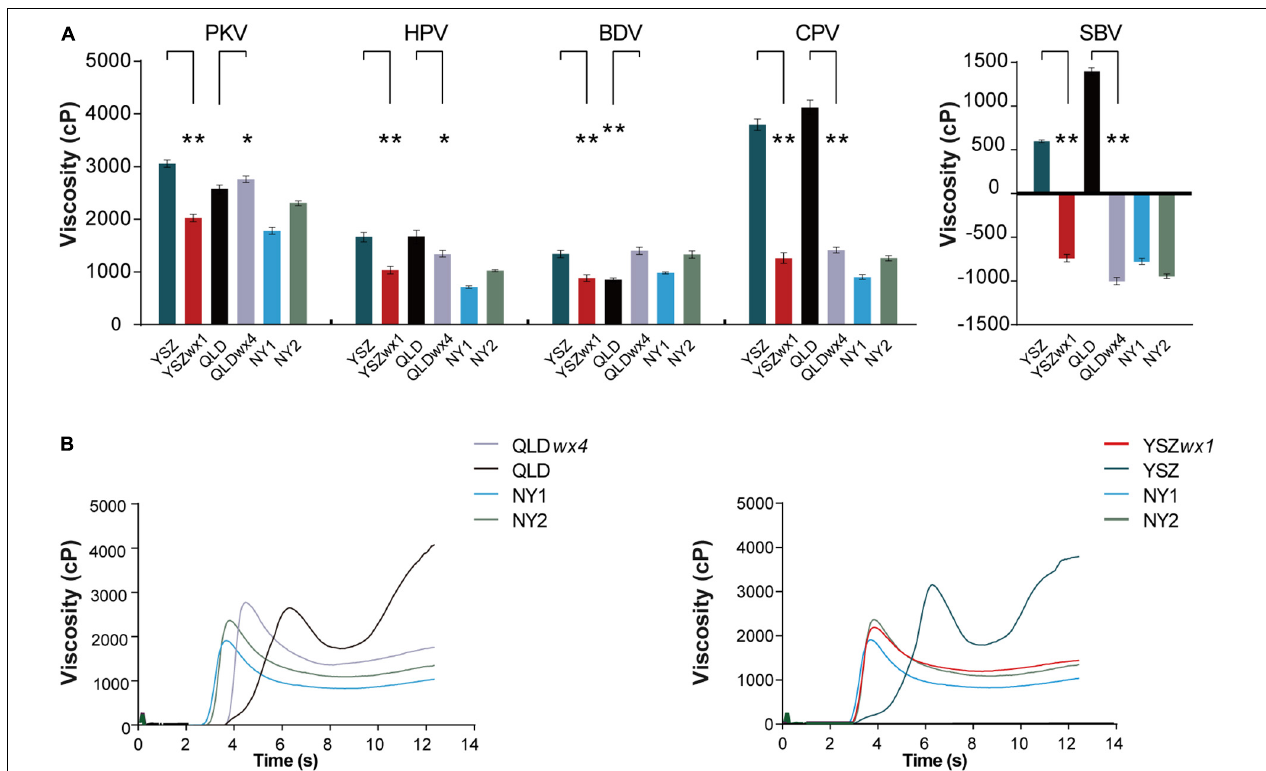
FIGURE 3 | Rapid viscosity analyzer profiles of rice starch in wx mutants and their corresponding WTs. (A) Rapid viscosity analyzer (RVA) profiles of starch in wx mutants and their corresponding WTs. (B) Rapid viscosity analyzer profile curve of wx mutants and their corresponding WT flour samples. The date of peak viscosity (PKV), hot paste viscosity (HPV), cool paste viscosity (CPV), breakdown viscosity (BDV = PKV-HPV), and setback viscosity (SBV = CPV-HPV) were derived from the RVA profiles. NY1 is a japonica waxy rice variety (in blue), and NY2 is an indica waxy rice variety (in green). Error bars are mean ± SD ( n = 3). Significant differences were determined by Student’s t -test (* P < 0.05, ** P <